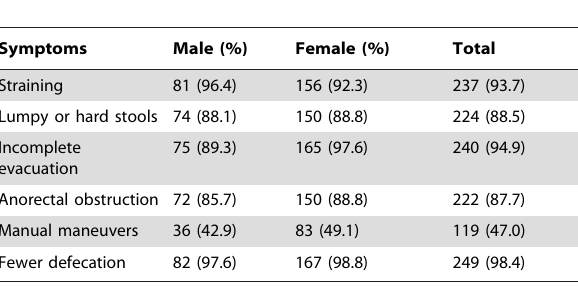
Table 3. Description of symptoms for students